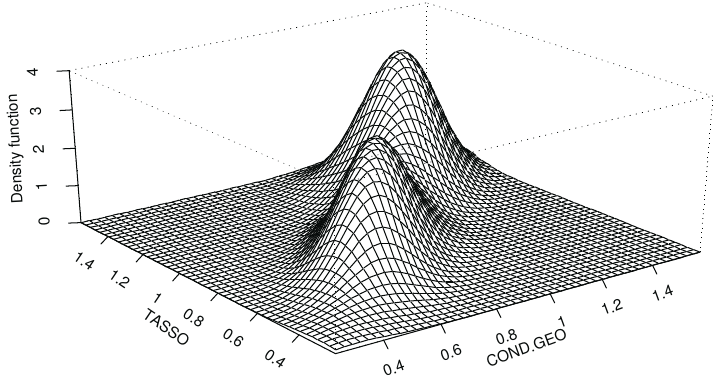
Figura 8 – Evoluzione da non condizionata a condizionata alla struttura geospaziale .